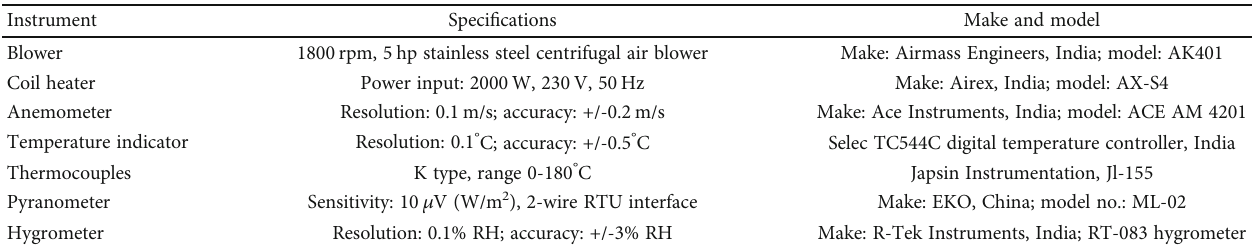
Table 2: Speci fi cations of the equipment and the instruments used in the present